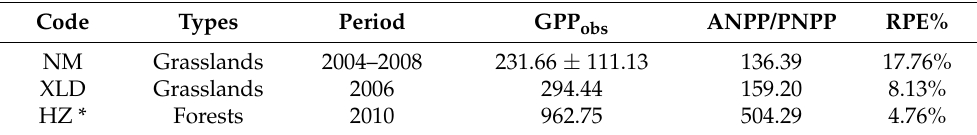
Table 3. Comparison of ANPP/PNPP with